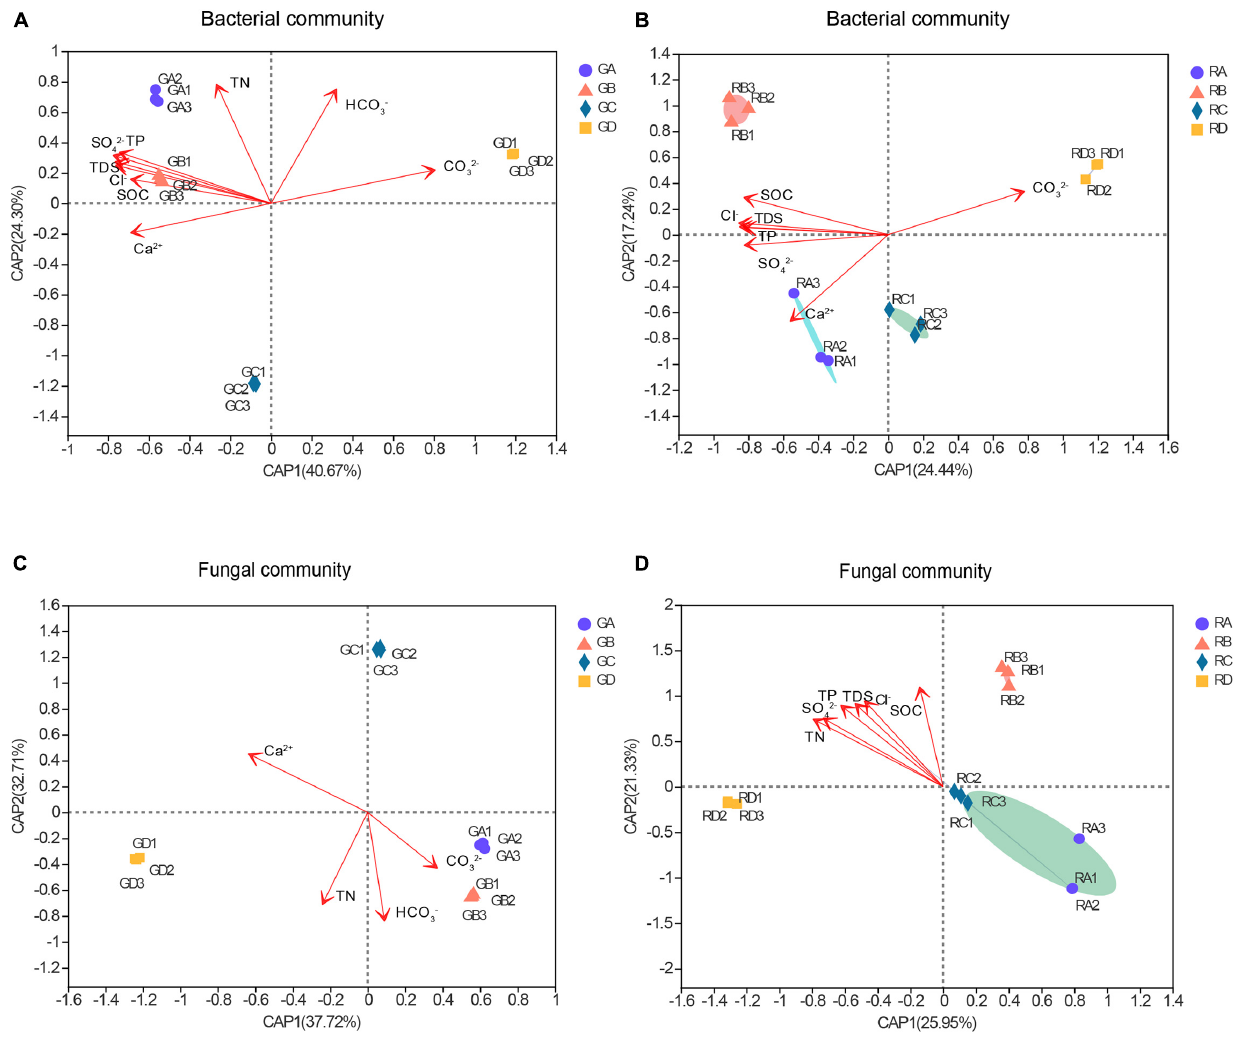
FIGURE 3 | The distance-based redundancy analysis (db-RDA) of these microbial community structure and environmental parameters. Numbers in parentheses in the axis labels was a percentage explanatory variable. (A) Bacterial rhizospheric samples, (B) bacterial endophytic samples, (C) fungal rhizospheric samples, and (D) fungal endophytic samples. S. europaea (A) , S. salsa (B) , P. communis (C) , and A. splendens (D)